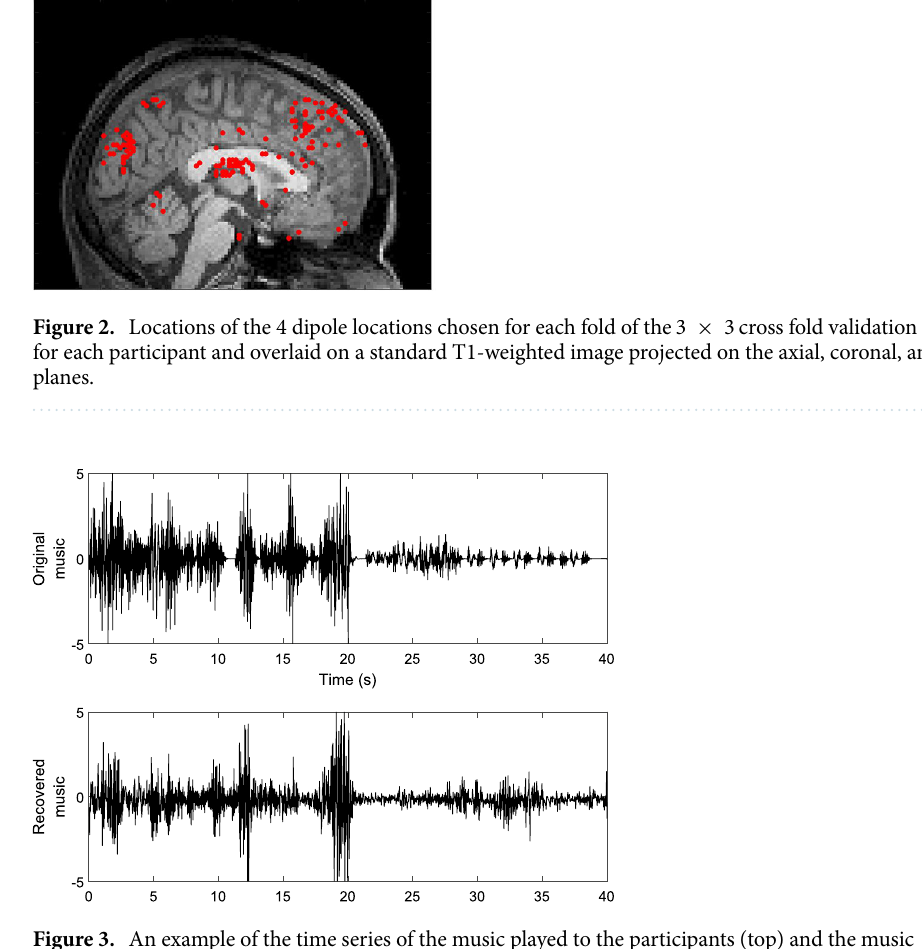
Figure 3. An example of the time series of the music played to the participants (top) and the music reconstructed via our fMRI-informed EEG source analysis and biLSTM decoder. The music is downsampled to the same sample rate as the EEG (1000 Hz) and the amplitudes have been